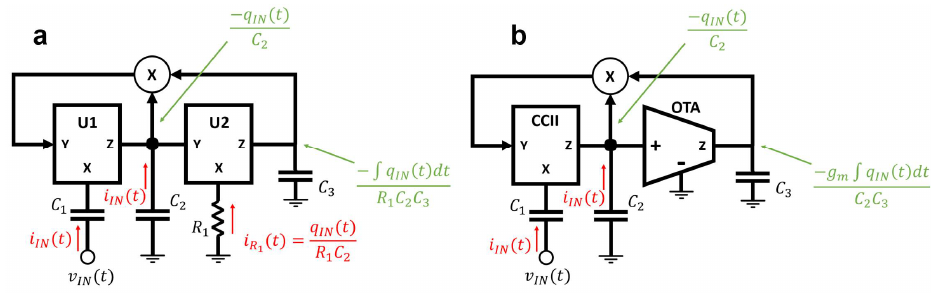
Figure 7. Memcapacitor emulator circuit proposed by Yesil and Babacan [47]. ( a ) Implementation based on only CCII, ( b ) implementation based on a CCII-OTA combination.